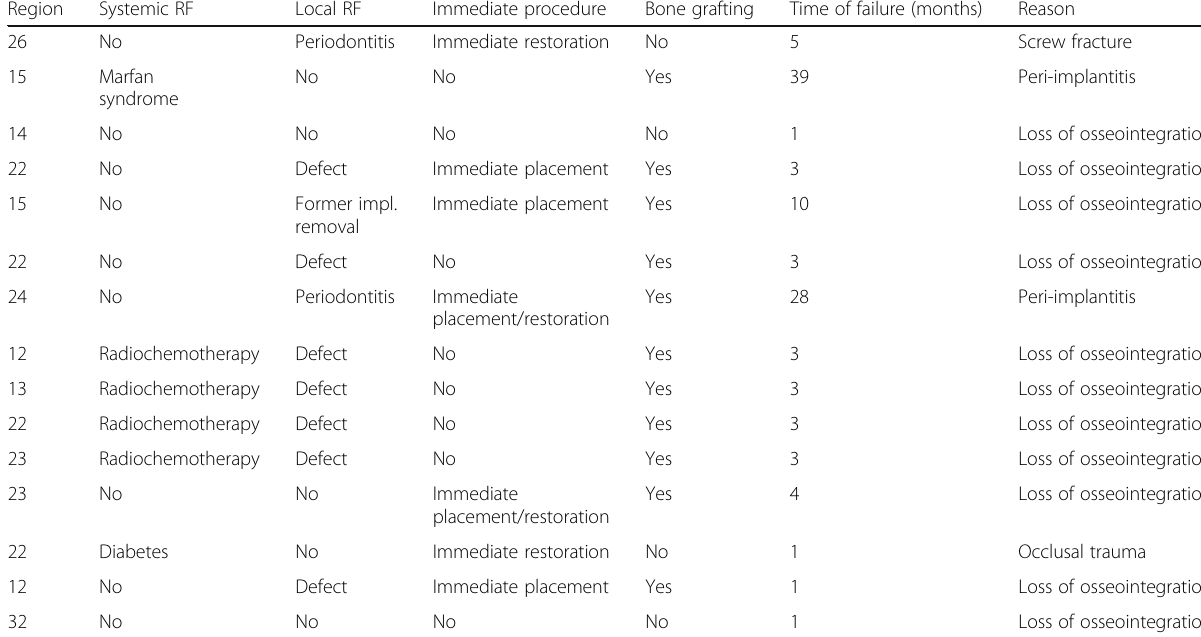
Table 2 Clinical parameters and reason for implant failures of 15 implants in 12 patients Region Systemic RF